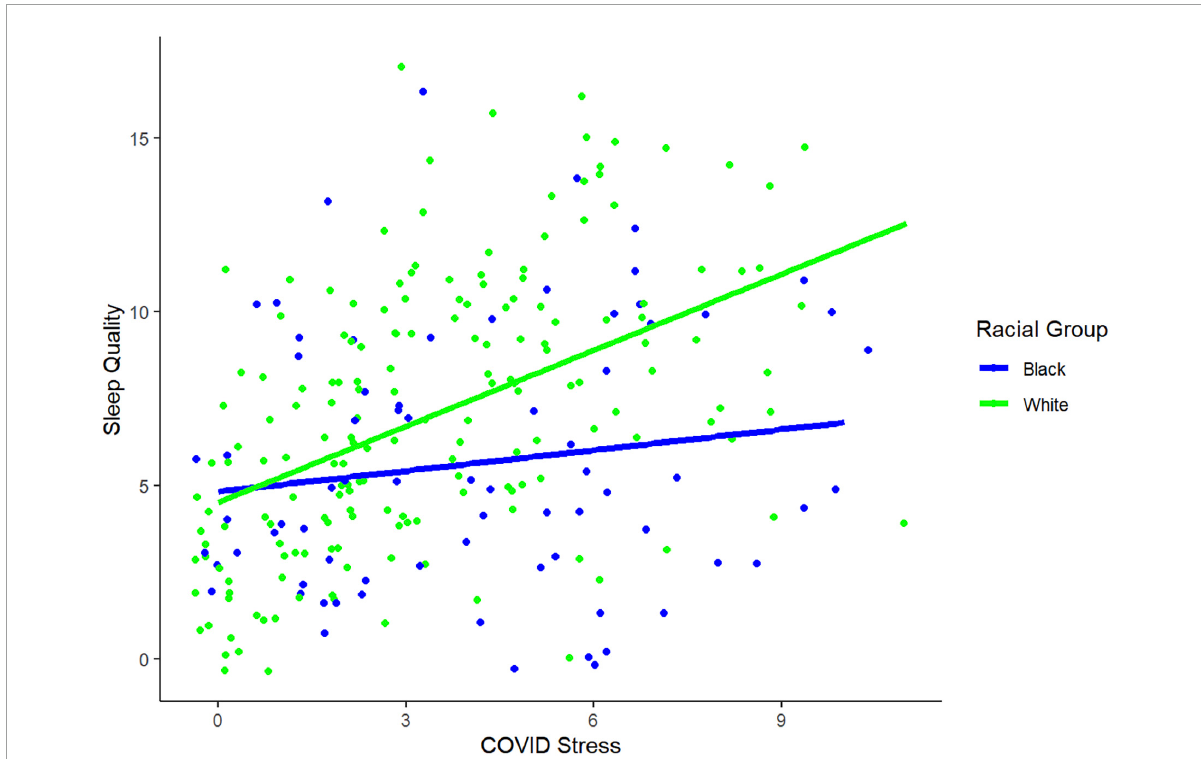
FIGURE1 Racial group differences in association between poor sleep quality and greater COVID stress. The plot demonstrates that White adults show stronger associations between COVID stress and sleep quality than Black adults. Jitter was applied to this plot to better visualize the data.